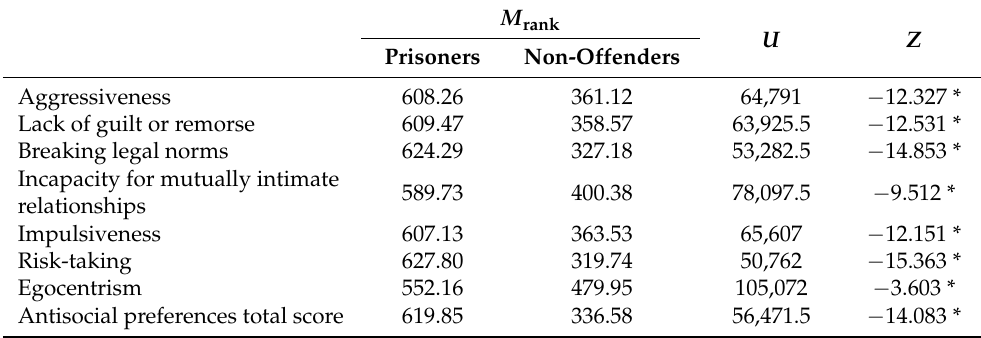
Table 8. Differences between prisoners and non-offenders on the dimensions of the Antisocial Preferences Scale.